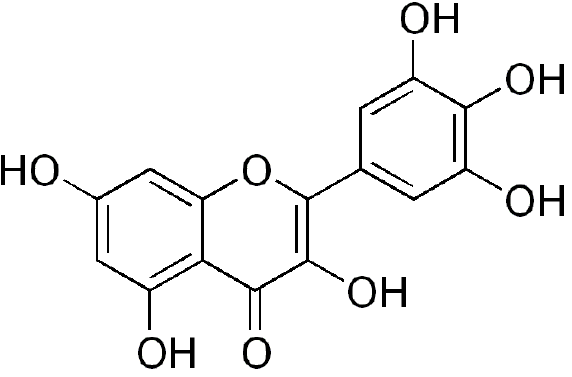
Figure 1. The chemical structure of myricetin (MYR; 3,5,7,3′,4′,5′-hexahydroxyflavone). Helicobacter pylori is a Gram-negative bacterium that colonizes the gastric mucosa